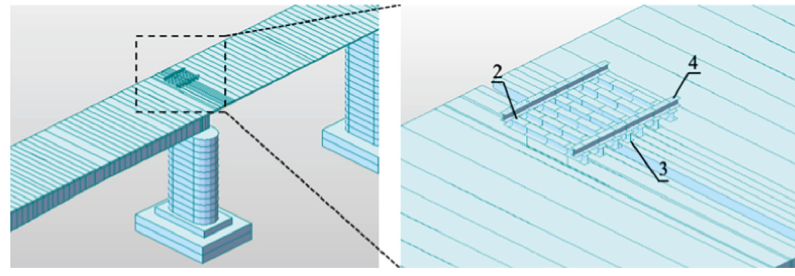
Figure 4: The MIDAS model of BEJs. Table 1: Parameters of different cases.